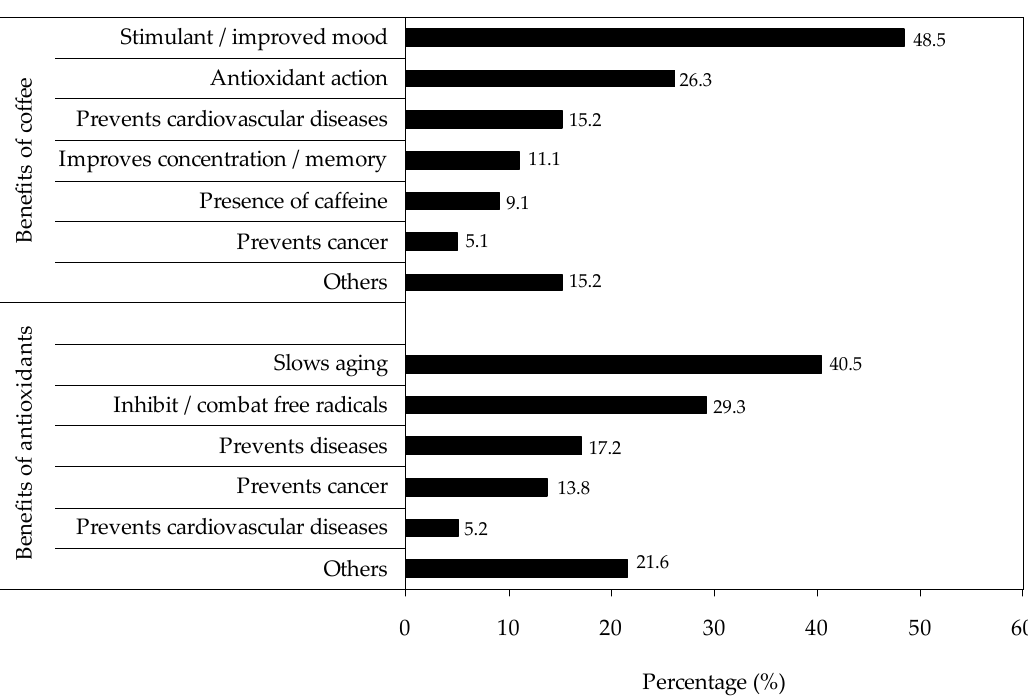
Figure 3. Consumers’ knowledge of the benefits of coffee intake ( n = 99, participants who answered yes with justification) and antioxidants ( n = 116).